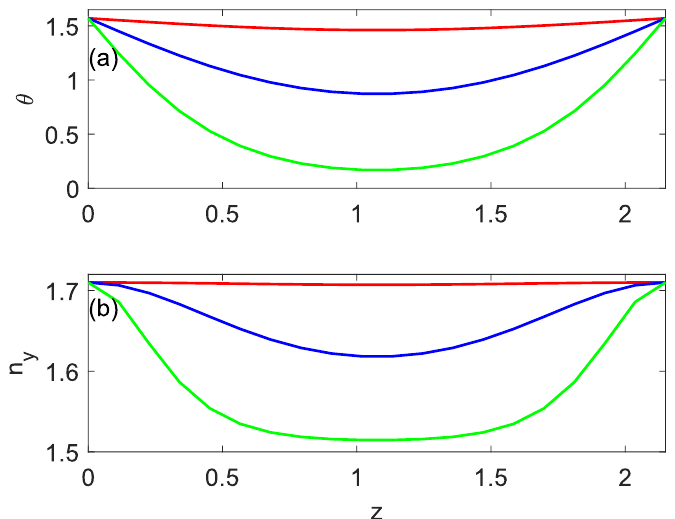
Figure 2. Distribution along an LC cell (along the Oz axis) of ( a ) LC director angle θ and ( b ) LC refractive index n y for light linearly polarized along the Oy direction. The thickness of the LC layer is d LC = 2.15 µ m. The voltage applied to the LC cell is: U LC = 0.48 V (red curves), U LC = 0.56 V (blue curves) and U LC = 1 V (green curves). The parameter values for E 7 liquid crystal used for solving Equation (1) are K = 3 × 10 − 12 N and ∆ (cid:101) =